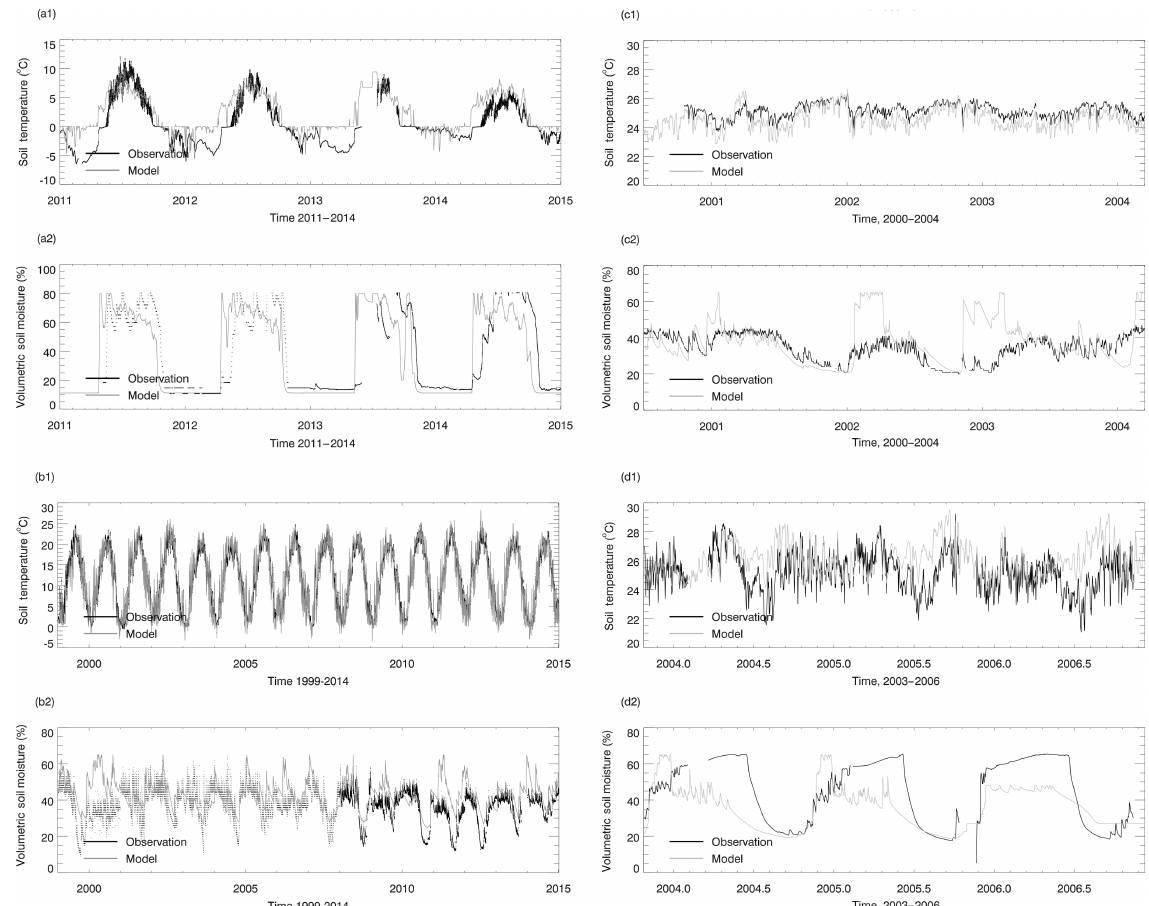
Figure 2. Evaluation of thermal and hydrology module at four sites: (a) Boreal evergreen needleleaf forests; (b) temperate deciduous broadleaf forests. (1) shows the soil temperature comparison between the model simulations (gray line) and observations (black line) and (2) shows the soil moisture comparison between the model simulations (gray line) and observations (black line). Specifically, the volumetric soil moisture is converted from the water content reflectometry (WCR) probe output period using an empirical calibration function of Bourgeau- Chavez et al. (2012) for the 5–30cm layer. Some of them resulted in calculations of values greater than 100% volumetric soil moisture (VSM) in the Nakai et al. (2013) study. Our model estimated high VSM (close to 80%) is due to top 10cm moss in the model, which has a saturation VSM of 0.8. Evaluation of the thermal and hydrology module at four sites: (c) tropical moist forest, (d) tropical forest–savanna. (1) shows the soil temperature comparison between the model simulations (gray line) and observations (black line) and (2) shows the soil moisture comparison between the model simulations (gray line) and observations (black